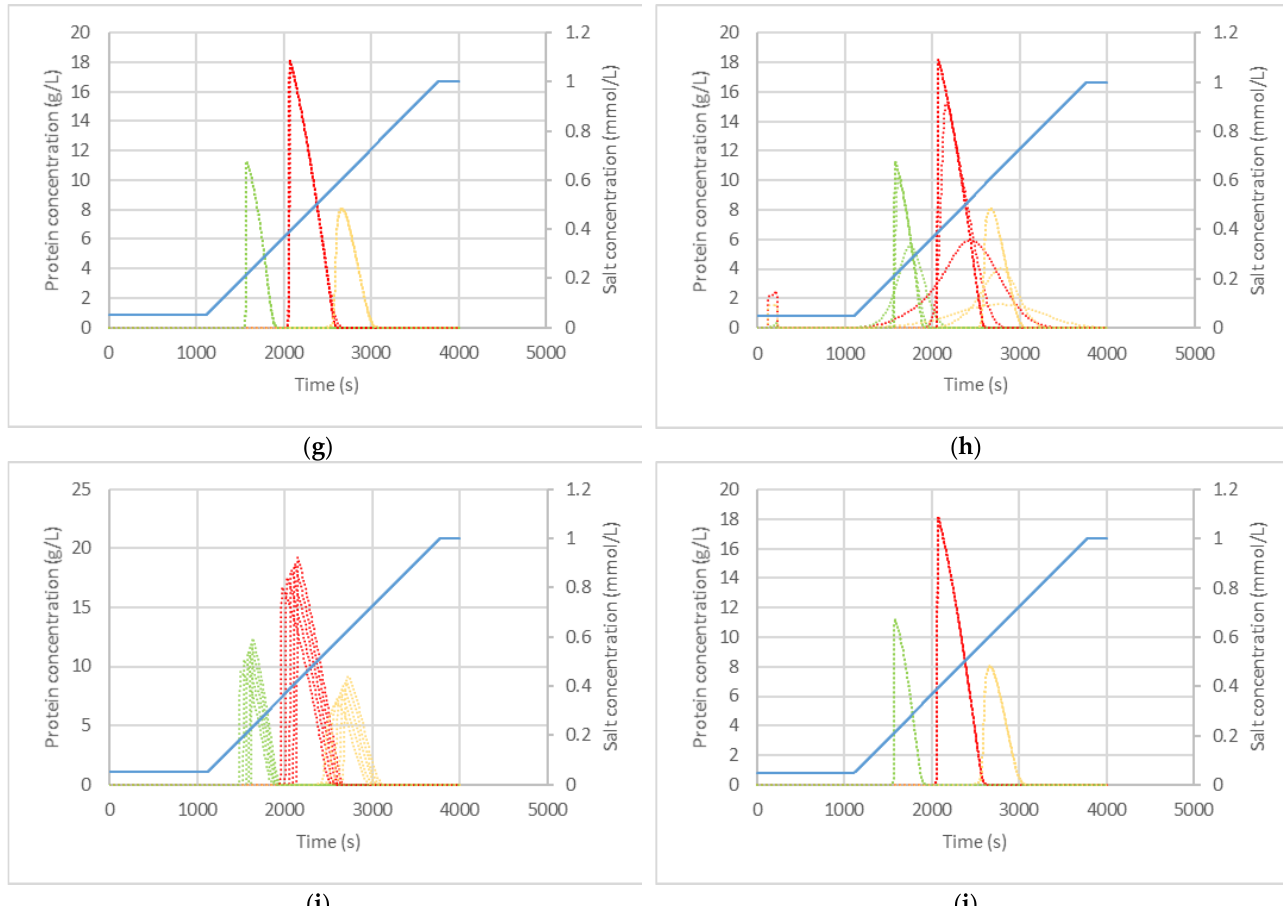
Figure 2. Shows the sensitivity analysis of the non a priori excluded parameters on each component. Green curves represent HCP1, red curves IgG, orange curves HCP2. Upper and lower variation ranges for the sensitivity analysis are given in Table 1. ( a ) Shows the impact on the chromatograms of parameters 𝑎 1,𝑖 , which describe the salt dependence of the henry coefficients. ( b ) Depicts the impact on the chromatograms of parameters 𝑎 2,𝑖 , which also describe the salt dependence of the Henry coefficients. ( c ) Illustrates the impact of the parameters 𝑏 1,𝑖 , which describe the salt dependence of the maximum loading capacities. ( d ) Depicts the impact of the parameters 𝑏 2,𝑖 , which also describe the salt dependence of the maximum loading capacities. ( e ) Shows the impact of the volume flow. ( f ) Shows the impact of 𝐷 𝑎𝑥 . ( g ) Depicts the impact of 𝑟 𝑝 . ( h ) Shows the impact of 𝑘 𝑒𝑓𝑓,𝑖 . ( i ) Illustrates the impact of 𝜀 𝑠 . ( j ) Shows the impact of 𝜀 𝑝 .